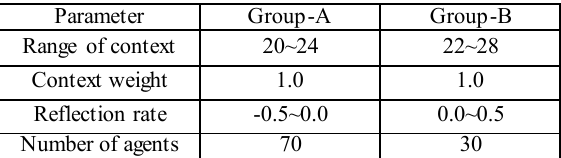
Table 5. The context models of two groups. Parameter Group-A